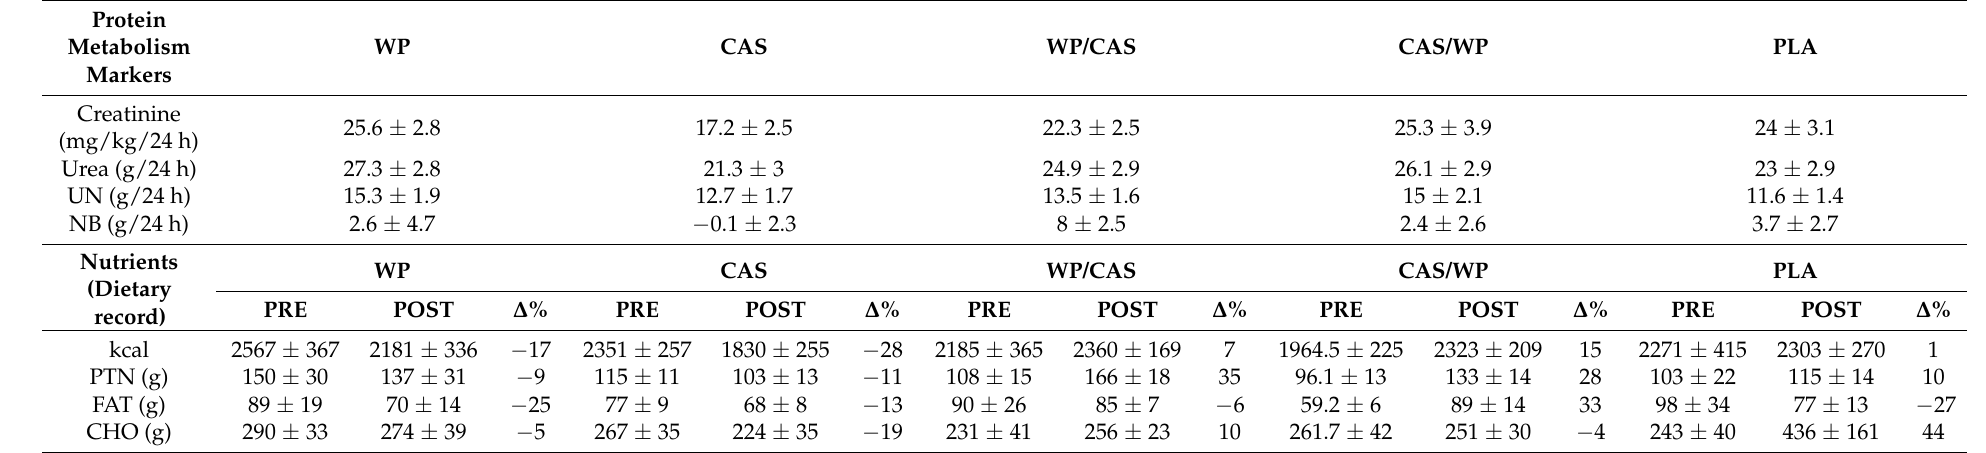
Table 4. Protein metabolism markers post each treatment and the nutritional assessments pre and post the